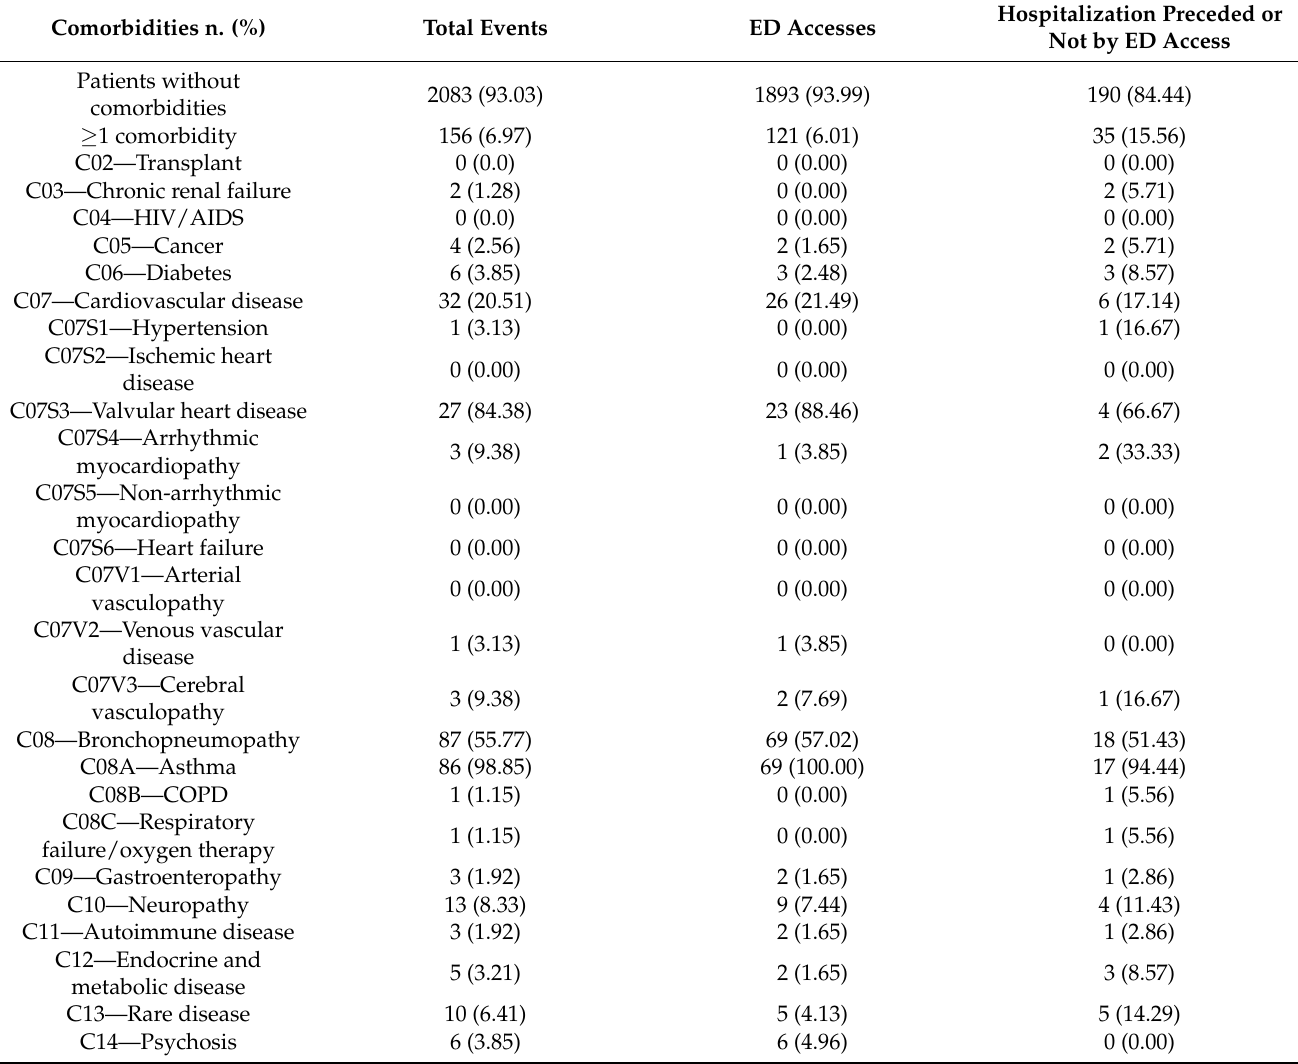
Table 2. Comorbidities in Ligurian children aged 0–17 years old with an ED access/hospitalization for varicella, study period 2010–2017. Comorbidities n.